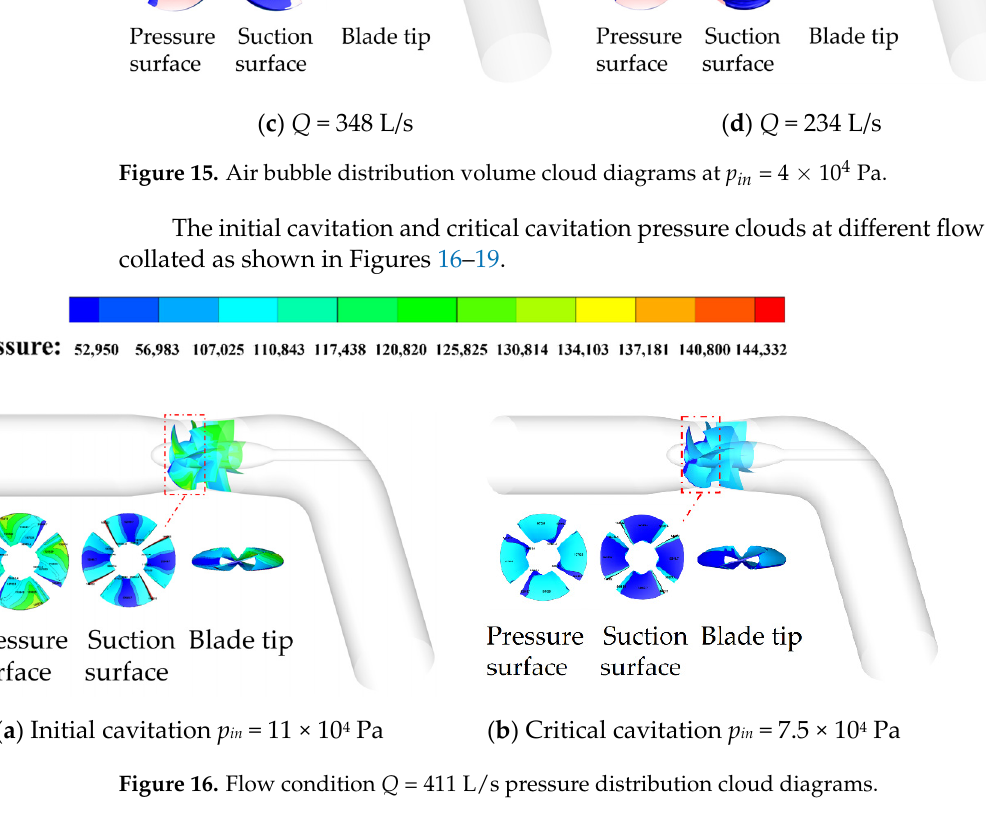
Figure 15. Air bubble distribution volume cloud diagrams at p in = 4 × 10 4 Pa.